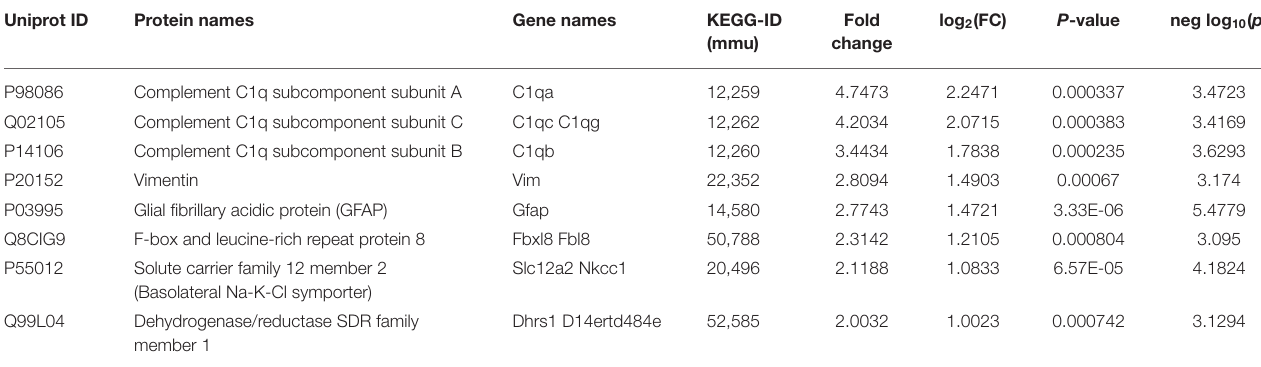
TABLE 3 | The impact of intracerebral electrode implants on altered protein expression in the hippocampus. Uniprot